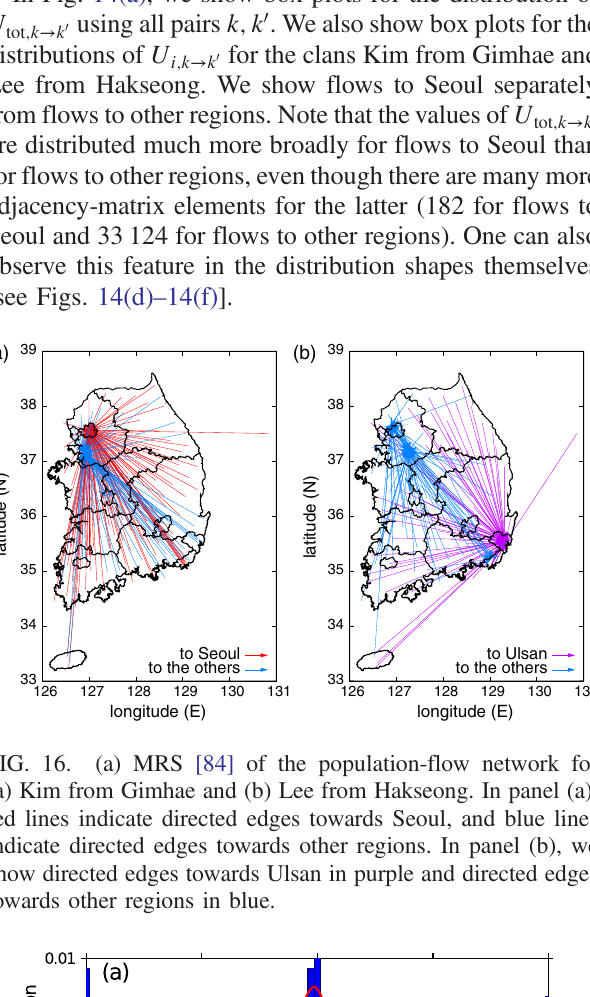
FIG. 18. Scatter plots of (a) distance between clan origin location and population centroid versus number of administrative regions, (b) distance between clan origin location and population centroid versus radius of gyration, and (c) radius of gyration versus number of administrative regions. (In this figure, we consider the 3 481 clans for which data are available in both the 1985 and 2000 censuses; we were able to determine the origin location for 3 120 of these clans.) The corresponding Pearson correlation values are (a) r ≈ − 0 . 0094 (from the 3 120 clans for which we know the origin location; the p -value is p ≈ 0 . 60 ), (b) r ≈ 0 . 14 (from the FIG. 17. Distributions of clan-density anomalies f ϕ in 2000 i g 3 120 clans for which we know the origin location; the p -value is over the 199 standardized administrative regions for (a) Kim from p ≈ 1 . 1 × 10 − 15 ), and (c) r ≈ − 0 . 26 (from the 3 481 clans; the Gimhae and (b) Lee from Hakseong. The leftmost and rightmost p -value is p ≈ 1 . 8 × 10 − 53 ). Note that correlations over limited peaks correspond, respectively, to all values less than or equal to − 500 and all values greater than or equal to 500. Solid curves are ranges can be different and significant. For example, in panel (c), the two diagnostics for ergodicity are significantly positively kernel density estimates (from M ATLAB R2011a ’ s KSDENSITY < 50 km ( r ≈ 0 . 39 , p ≈ 2 . 3 × 10 − 4 correlated when r function with a Gaussian smoothing kernel of width 20). g